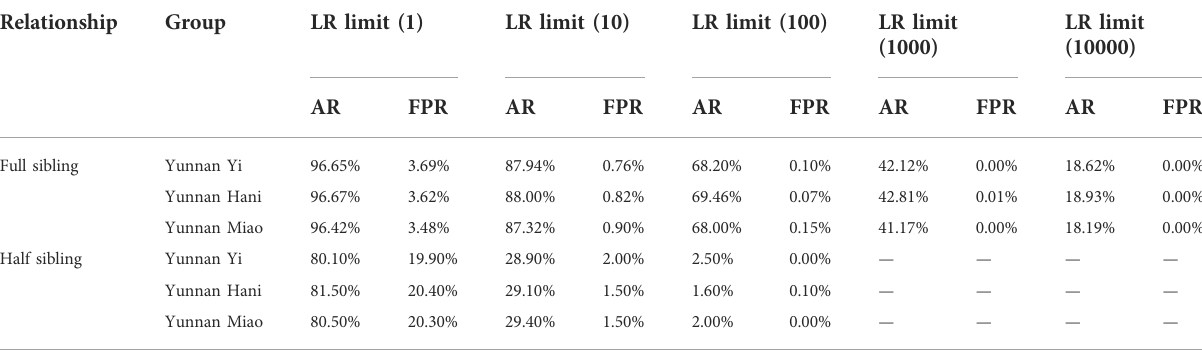
TABLE 1 The accuracy rates and false positive rates of the full sibling and half sibling identi fi cations based on 43 A-DIPs frequencies with the method of likelihood ratio.